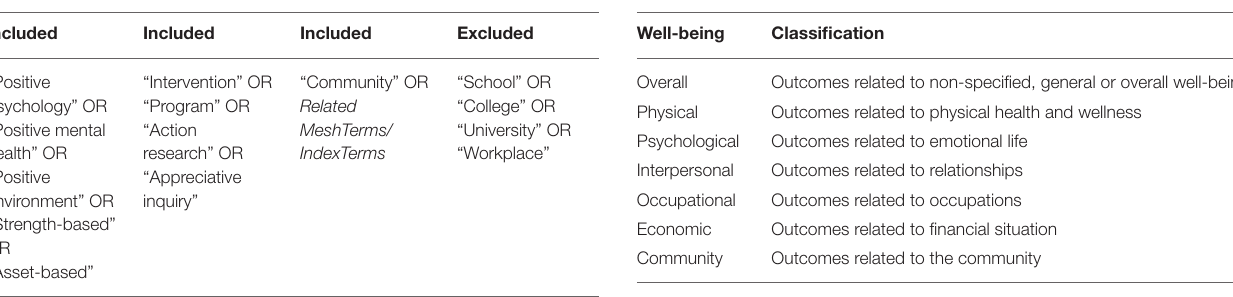
TABLE 2 | Classification of well-being outcomes derived from the I COPPE